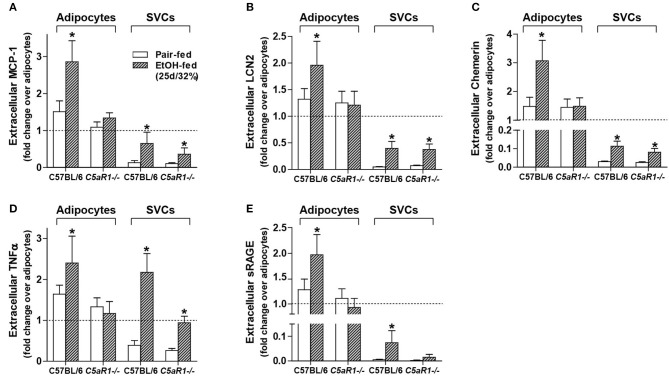
Ethanol-induced secretion of adipokines from isolated adipocytes, but not SVCs, is C5aR1-dependent. WT and C5aR1−/− mice were allowed free access to ethanol (32%, d25) or pair-fed control diets. Adipocytes and stromal vascular cells (SVCs) were isolated following collagenase digestion. Spontaneous secretion of (A) MCP-1, (B) LCN2, (C) Chemerin, (D) TNFα, and (E) sRAGE was quantified from isolated adipocyte and SVC supernatants by ELISA. For adipocytes, data are represented as fold change accumulation after 30 min (LCN2, chemerin, sRAGE) or 60 min (MCP-1, TNFα) compared to the respective basal time zero of that group. SVC data are fold change accumulation after 60 min compared to adipocyte basal time zero within each respective genotype and treatment. Values represent means ± SEM, values with * were significantly different from genotype pair-fed controls (P<0.05). n = 6–8 pair-fed and n = 6–8 EtOH-fed mice.